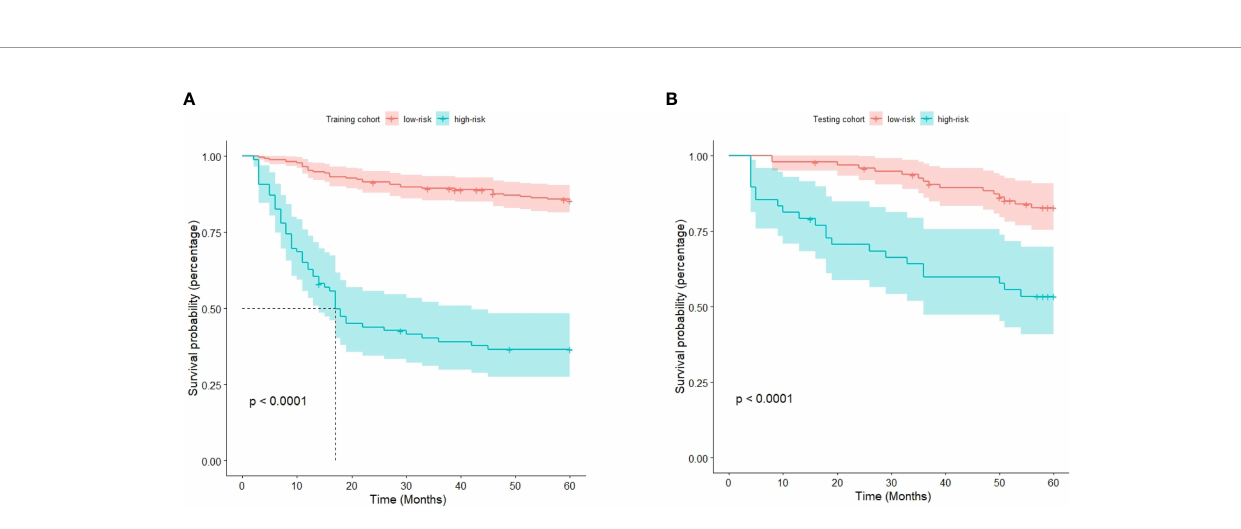
FIGURE 6 | Kaplan ‒ Meier curves for overall survival in the training cohort (A) and testing cohort (B)